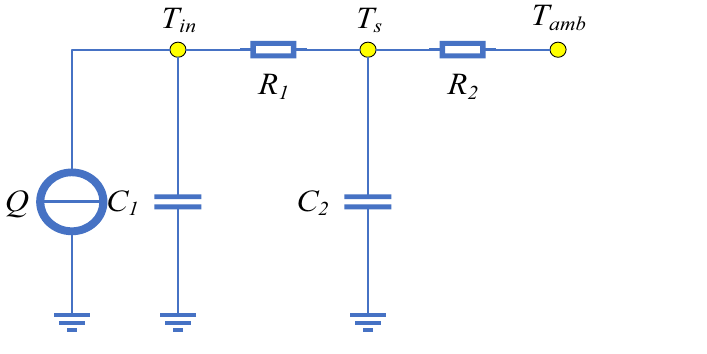
Figure 2. Two-node thermal